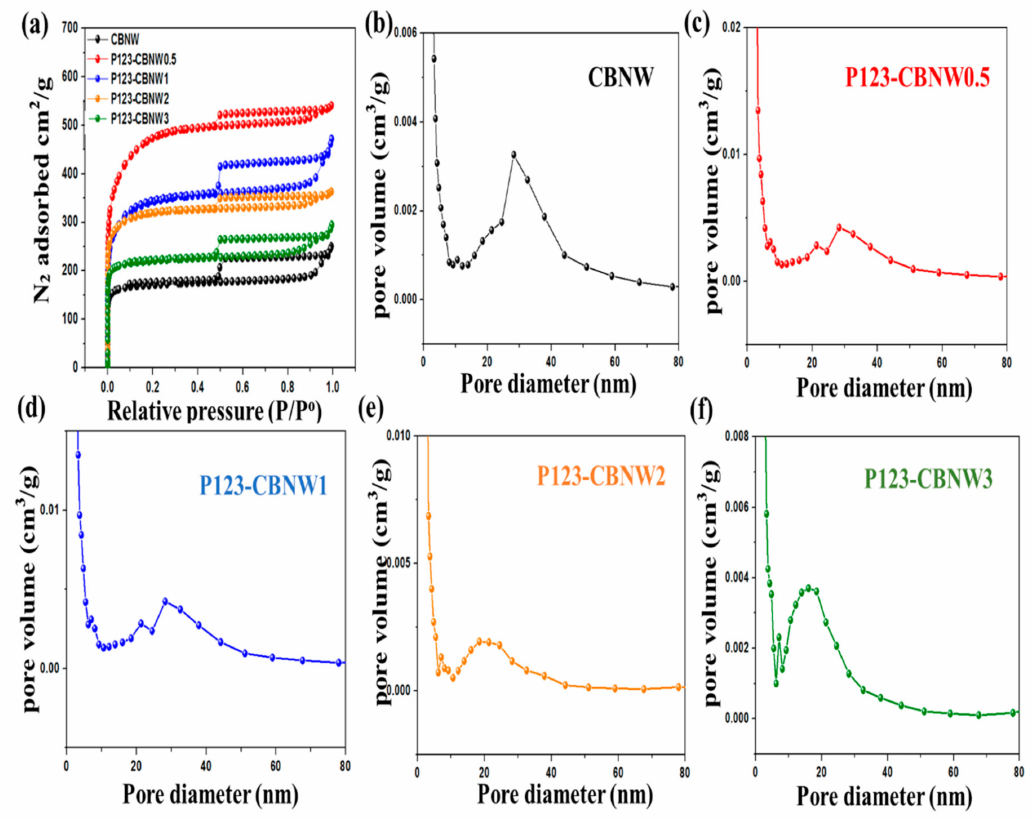
Figure 6. ( a ) N 2 adsorption-desorption isotherms of prepared samples at 77 K, ( b–f ) non-local density functional theory equation (NLDFT)-pore size distribution plots of respective